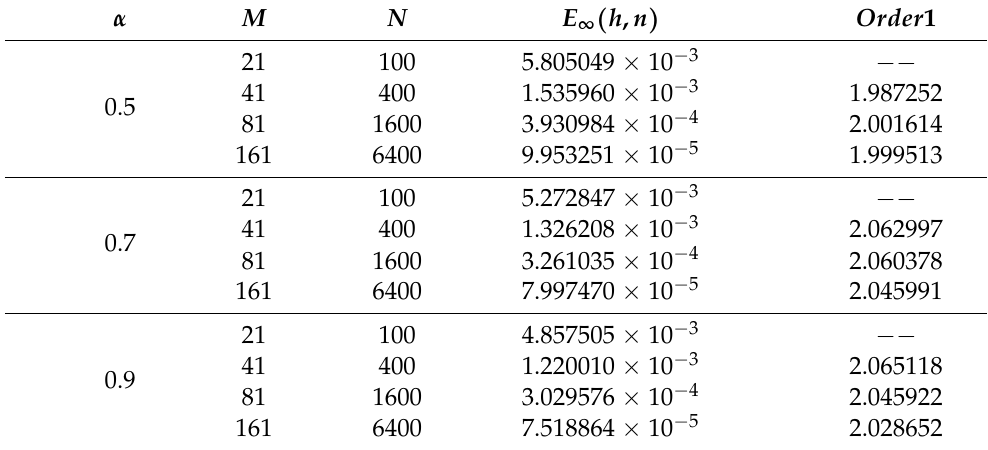
Table 2. Numerical error and spatial convergence order of HASC-N difference scheme for Example 1.